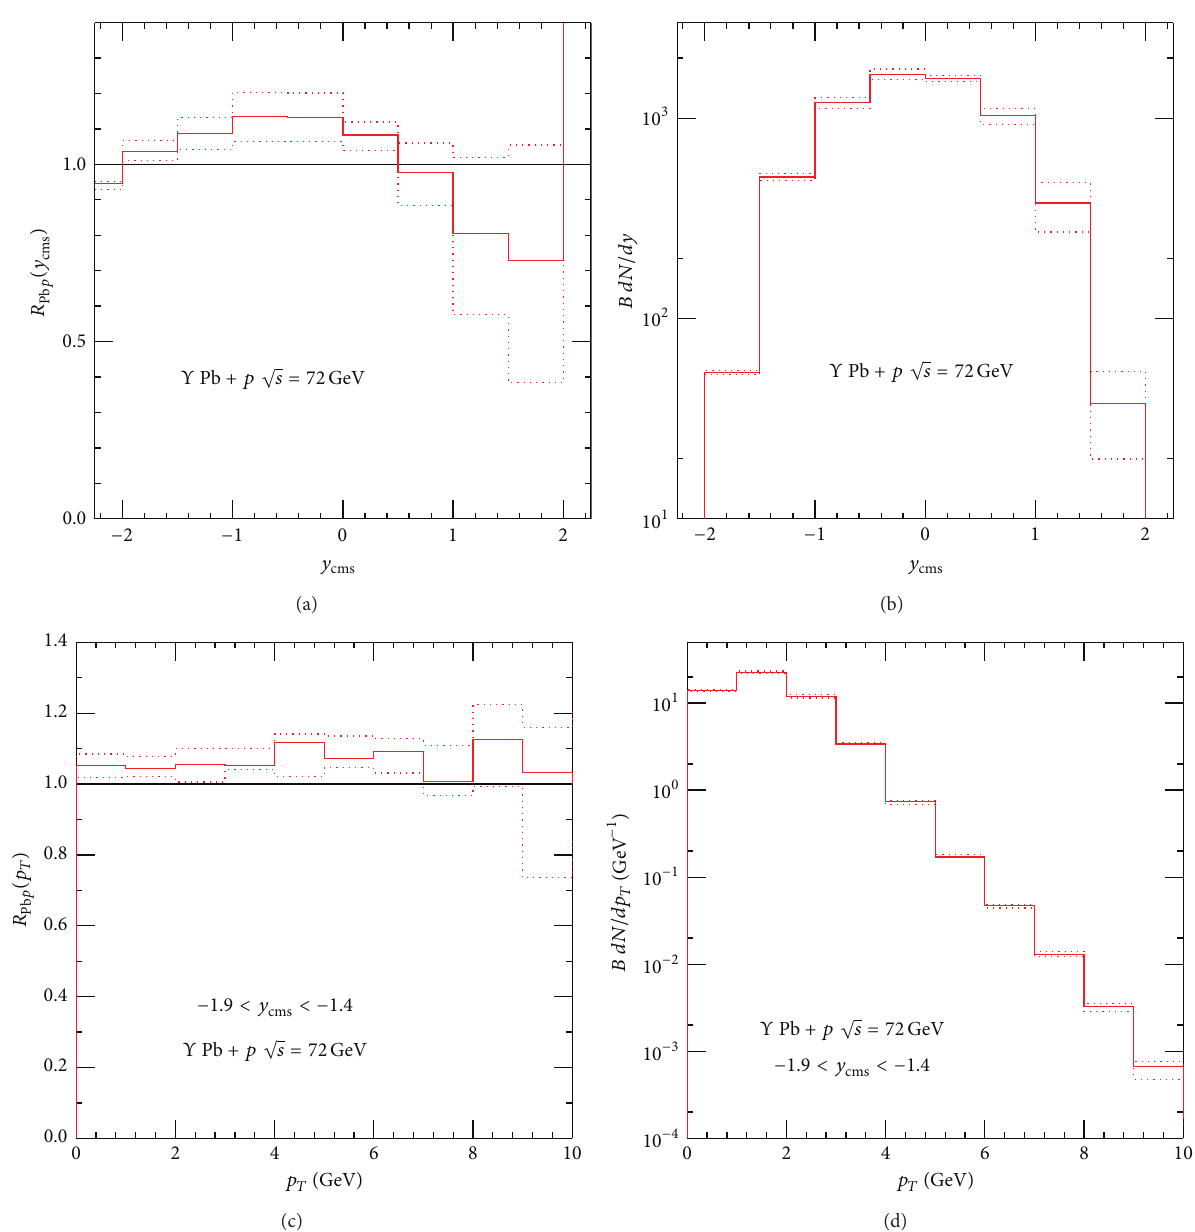
Figure 5: The predicted Υ(1𝑆) shadowing ratios (a, c) and rates (b, d) as a function of center of mass rapidity (a, b) and 𝑝 𝑇 (c, d) for Pb + 𝑝 collisions at √𝑠 𝑁𝑁 = 72 GeV. The solid curve in each plot is the central EPS09 NLO result, while the dotted curves outline the shadowing uncertainty